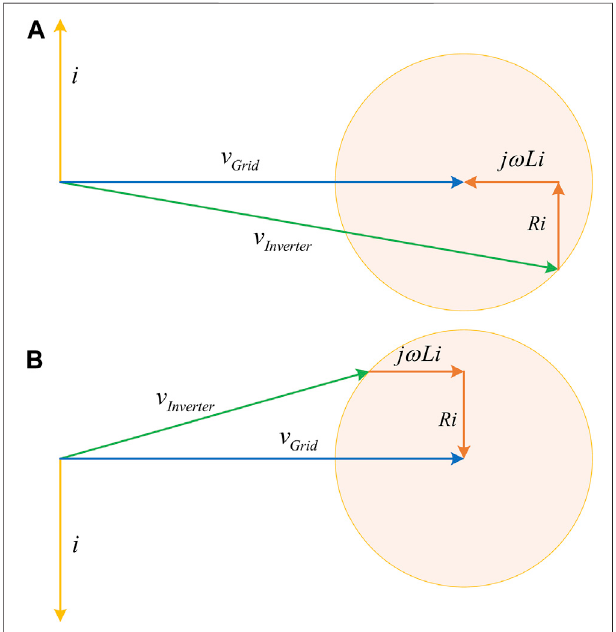
FIGURE 2 | Voltage vector diagrams of two typical operation modes (A) is the capacitive mode (B) is the inductive mode.